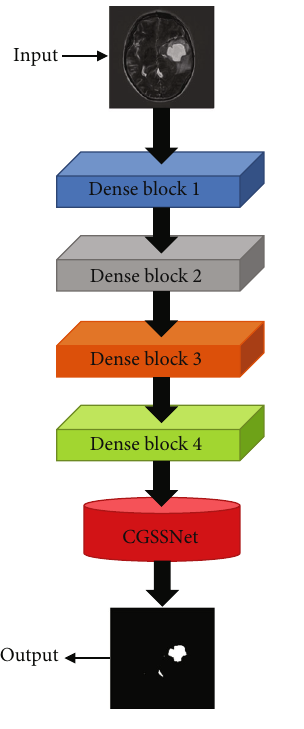
Figure 6: Schematic diagram for structure of CGSSNet.